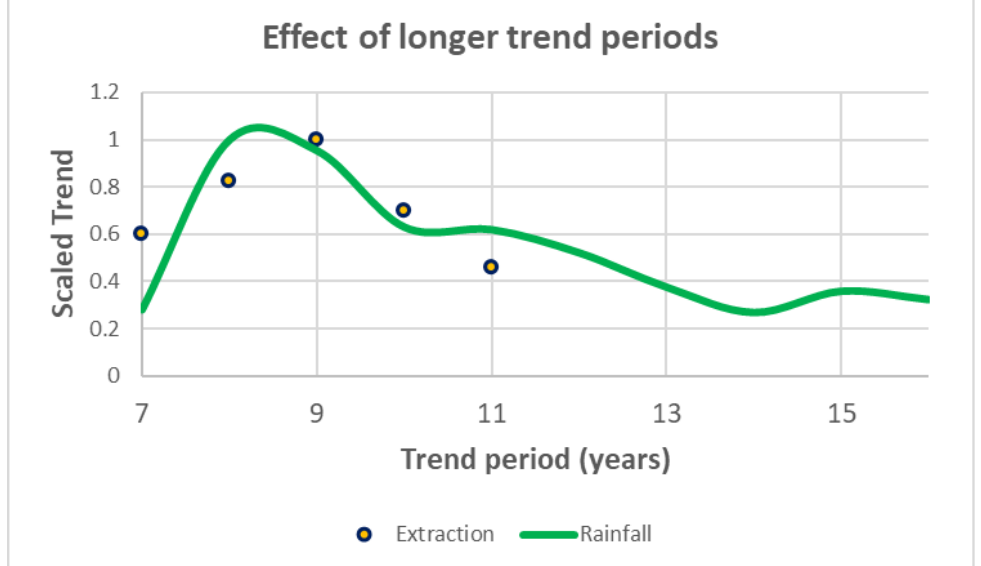
Figure 8. Plot showing the effect of longer time periods on trend estimates for both annual rainfall and extraction. Estimates of slope were obtained by least-squares linear regression of rainfall or extraction against time for a period up to 2019–2020. The x -axis represents the start of the trend